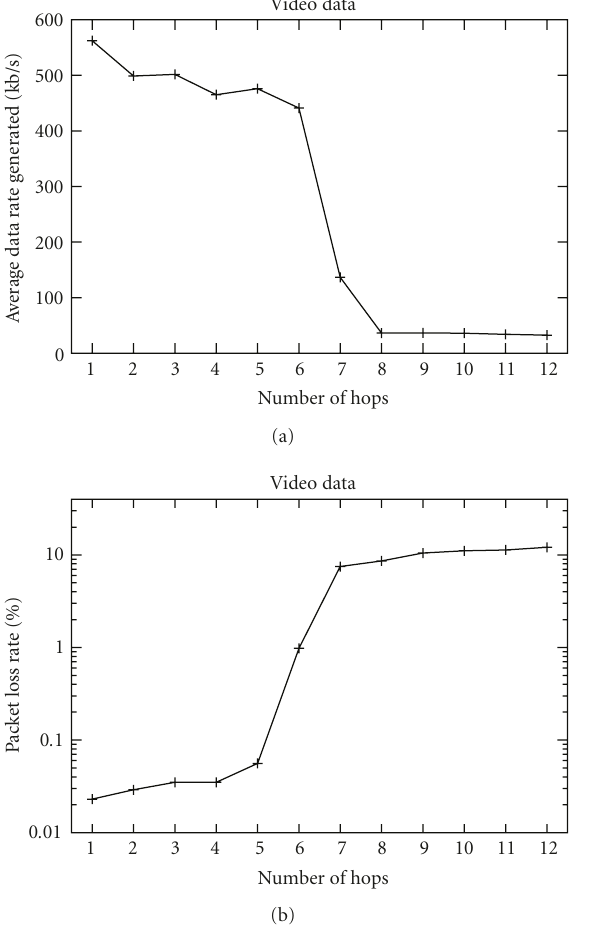
Figure 25: Cumulative distribution function for the throughput in a scenario with di ff erent hops (b) and packet loss rate in di ff erent scenarios (a).